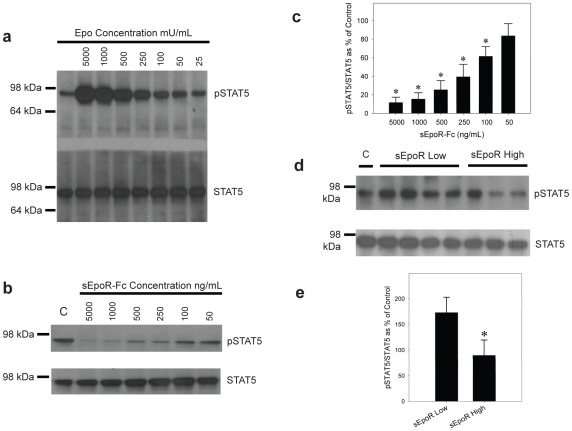
Functional characterization of sEpoR.
3a. Western blot showing increasedphospho-Stat-5 in the presence of increasing erythropoietin (25 to 5000 mU/ml) in BaF3/EpoR cell lysates. 3b. Representative western blot showing total phospho-Stat-5 and Stat-5 in the presence of erythropoietin 5000 mU/ml and varying concentrations of recombinant sEpoR-Fc (50 -5000 ng/ml). Phospho-Stat-5 decreases with increasing recombinant sEpoR. 3c. Quantification of sEpoR-Fc inhibition of phospho-Stat 5 (Figure 3b). Ratios of phospho/total Stat-5 (mean ± SD, n = 3) represented as a percentage of control (Epo alone). *represents p<0.05. 3d. Serum from patients with high sEpoR blocks erythropoietin mediated Stat-5 phosphorylation. Shown is the ratio of phospho-Stat-5 to Stat-5 as measured by densitometry. Serum starved BaF3/EpoR cells were exposed to vehicle (negative control), erythropoietin at 50 mU/ml (positive control) and erythropoietin plus 10% serum with Low sEpoR (≤62.5 pg/ml) or serum with high sEpoR (≥4000 pg/ml) for 10 minutes. Cells were lysed in RIPA buffer and 10 ug protein/lane was run on a 4-12% denaturing gel. Gels were transferred and blotted with anti-Stat-5 and anti-phospho-Stat 5. 3e. Quantification of western data (Figure 3d). Ratios of phospho/total Stat-5 (mean ± SD, n = 5 individual patient samples each for low sEpoR and high sEpoR) represented as a percentage of control (Epo alone). *represents p<0.05.